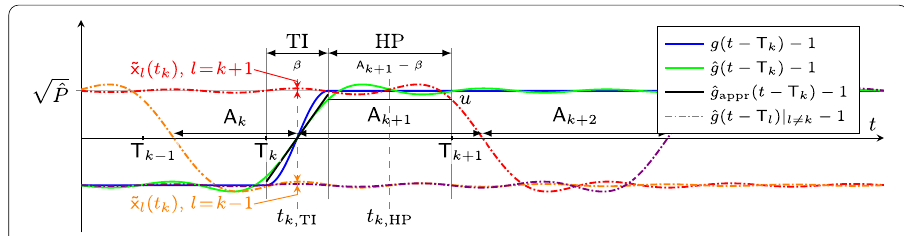
g ( t 1 , and interfering pulses T k ) ˆ − −